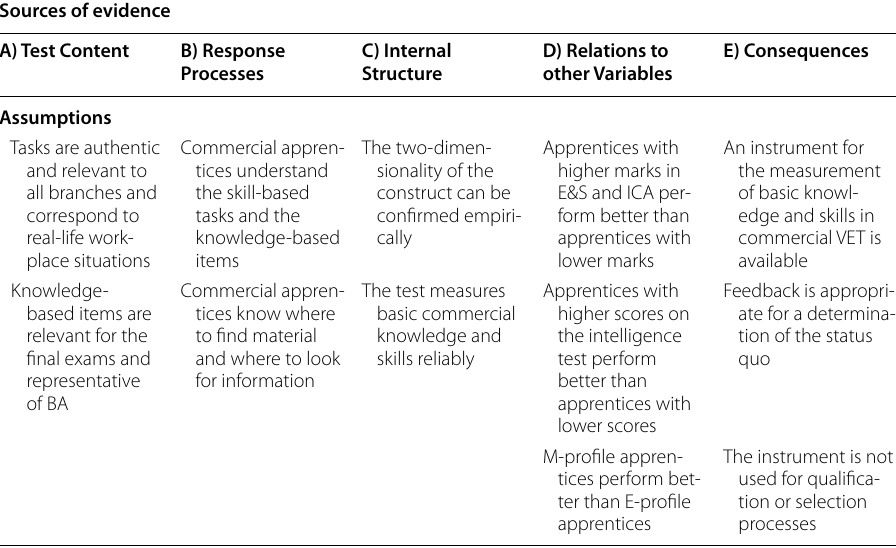
Table. 1 Assumptions made for test interpretation and use (to be tested in the subsequent steps) Sources of